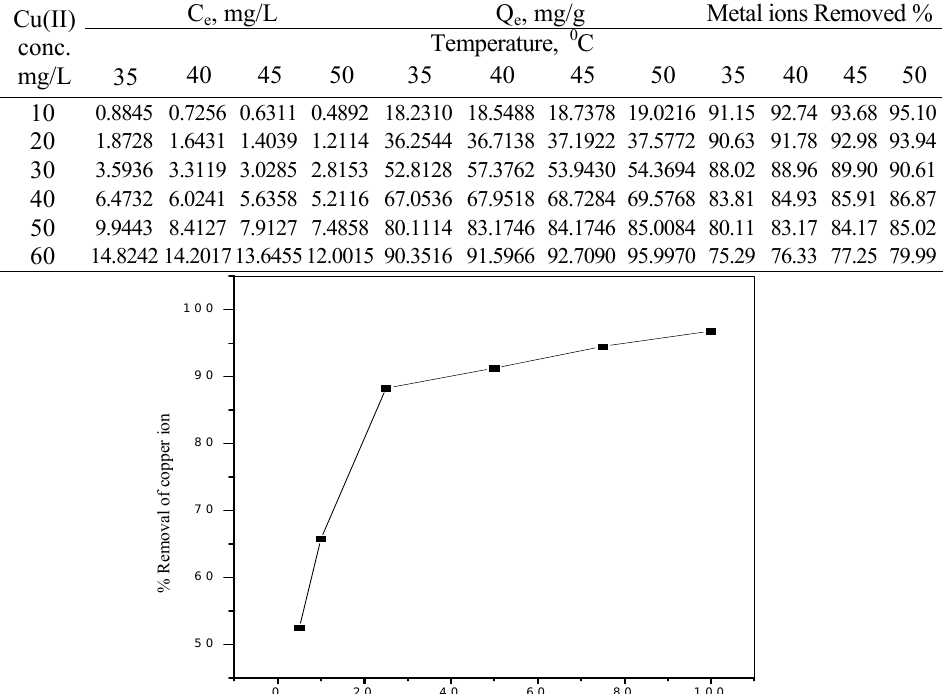
Table 2. Equilibrium parameters for the adsorption of copper ion by CBC